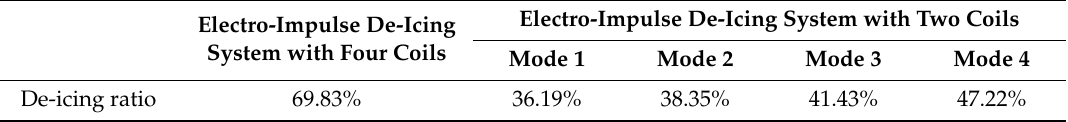
Table 6. De-icing ratio comparison.